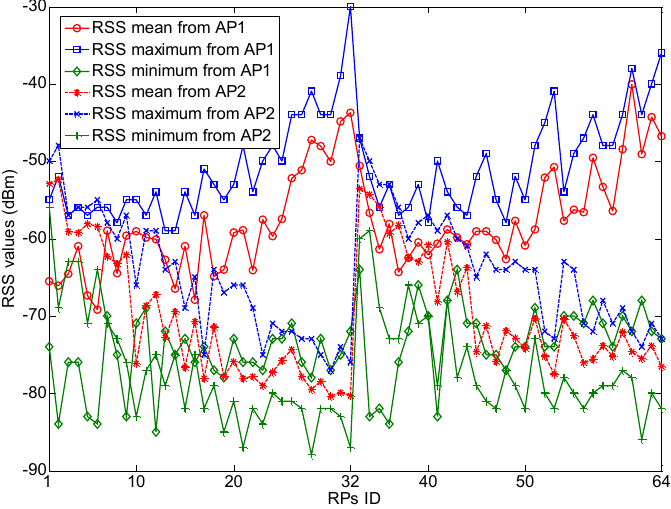
Figure 12. RSS variations in linear distribution model with two LOS visible APs.